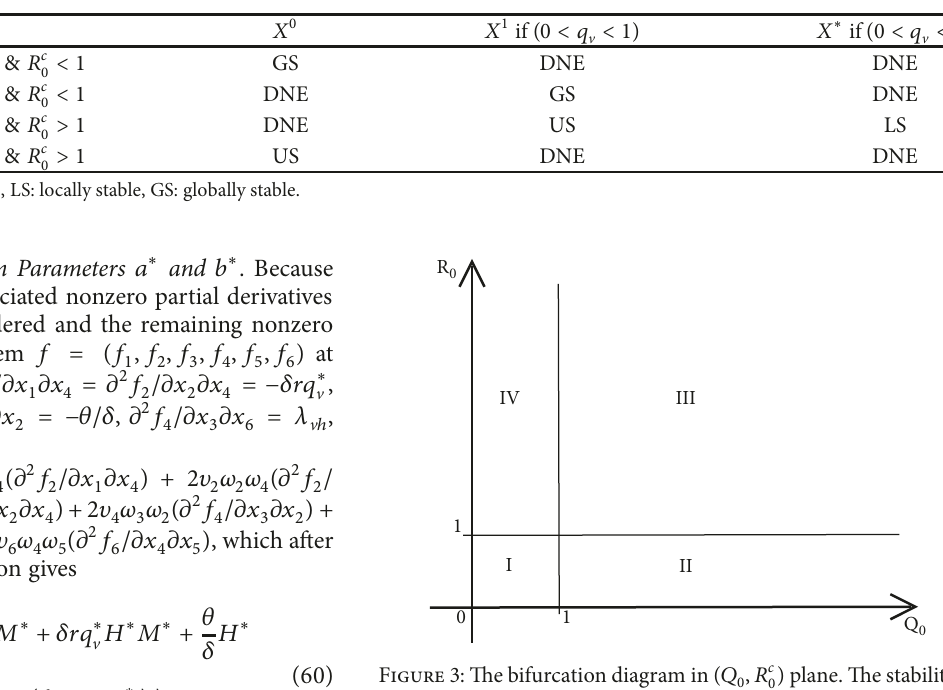
Table 1: Existence and stability of model equilibria.